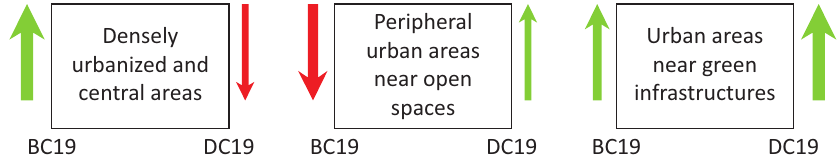
Figure 1. Hypothesized changes in the attractiveness of different types of urban areas before Covid‐19 (BC19) and during Covid‐19 (DC19). Note: Green arrows symbolize appreciation, red arrows depreciation, and the thickness of the arrows is their expected